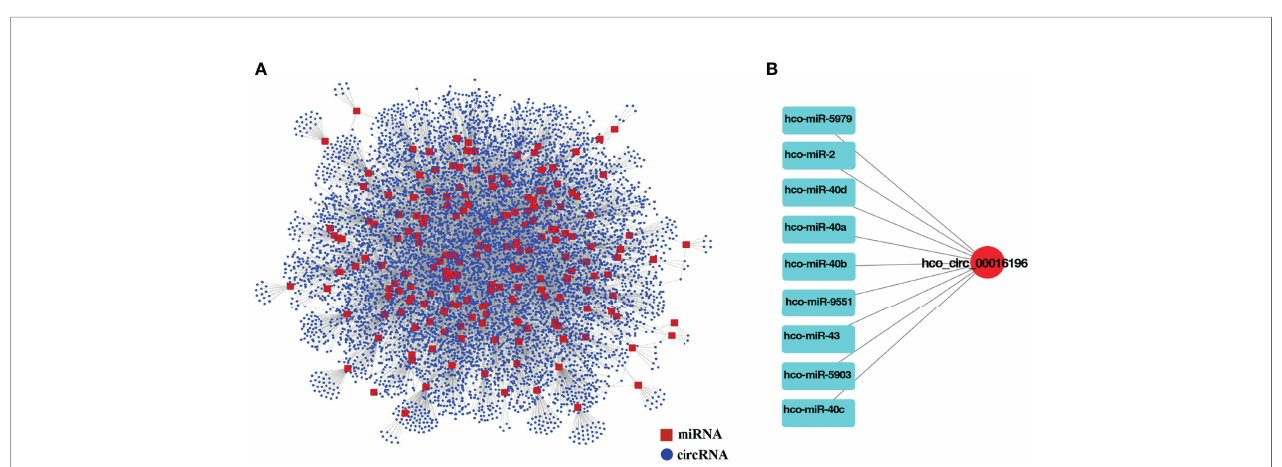
FIGURE 4 | (A) The interaction network of differentially expressed circRNAs and miRNAs for H . contortus. Red squares represent miRNAs, and blue nodes represent circRNAs. (B) The circRNA, hco_circ_00016196, and nine miRNAs interaction network. Red nodes represent circRNAs, and light blue squares represent